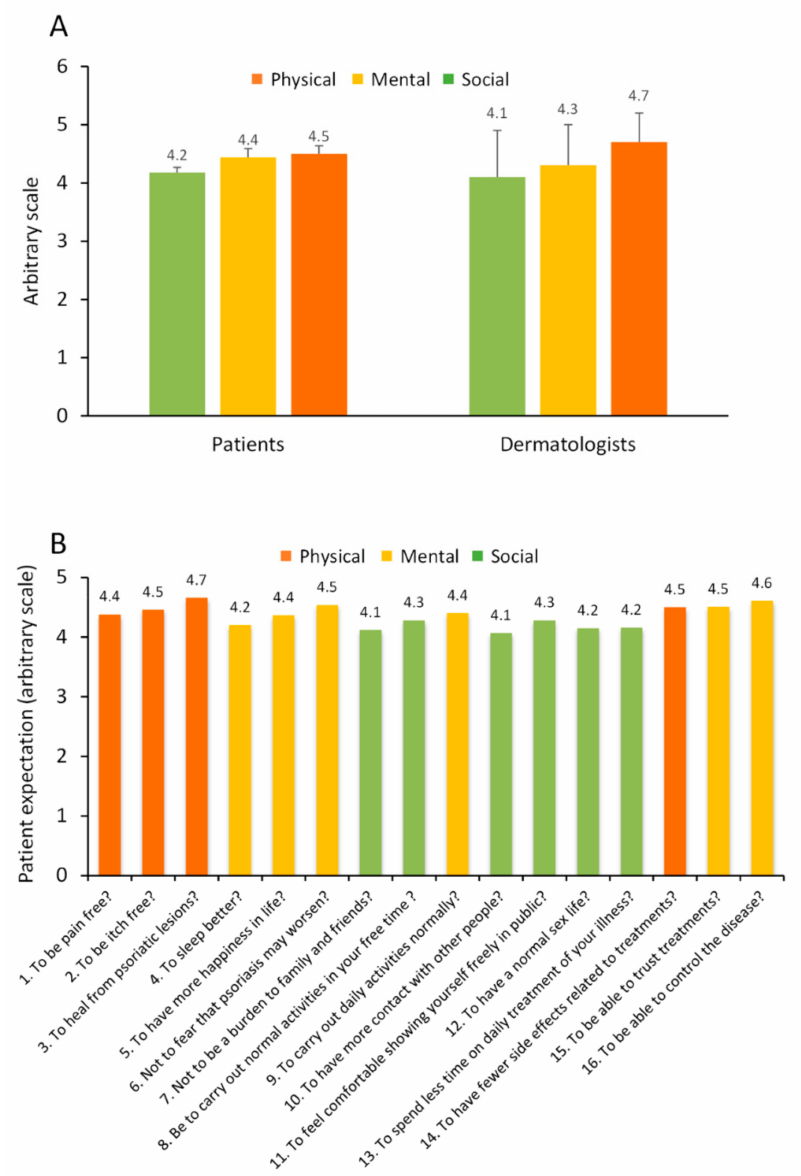
Figure 4. Rating of three core domains, physical, mental and social associated with achievement of patient wellbeing (“expectation”). ( A ) Perspective of patients and dermatologists on rating of three core domains associated with achievement of patient wellbeing. Data are presented as mean ±